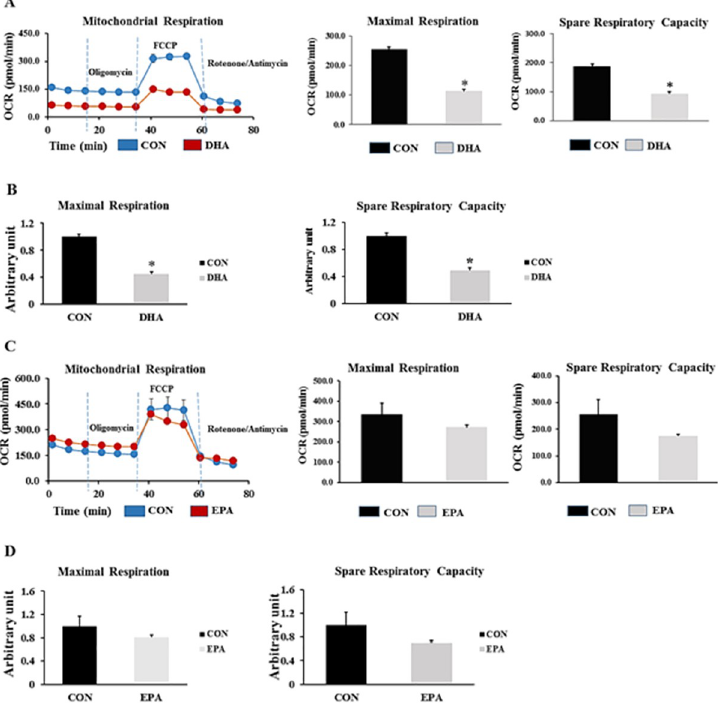
Fig 10. The effect of EPA and DHA separately on metabolic rate of C2C12 cells undergoing differentiation into brown adipocytes. The cells are treated with differentiation induction medium (DIM) in the absence (CON) or presence of individual doses of 50 μ M EPA and 50 μ M DHA for 7days. Vertical dashed lines indicate the times of addition of oligomycin (2 μ M), FCCP (0.7 μ M), and antimycin A (10 μ M) (A) the effect of DHA treatment on maximal respiration and spare respiratory capacity. OCR traces are expressed as pmol O2 per min in C2C12 cells and normalized to protein concentration (B). The Relative differences in maximal respiration and spare respiratory capacity of control and DHA treated group (C) The effect of EPA supplementation on maximal respiration and spare respiratory capacity. OCR traces are expressed as pmol O2 per min in C2C12 cells and (D) the relative changes in maximal respiration and spare respiratory capacity are measured in arbitrary units, n = 3 and 12 measurements. Data are represented as mean ± SEM. The significant difference is presented as � P < 0.05, Student’s t test.